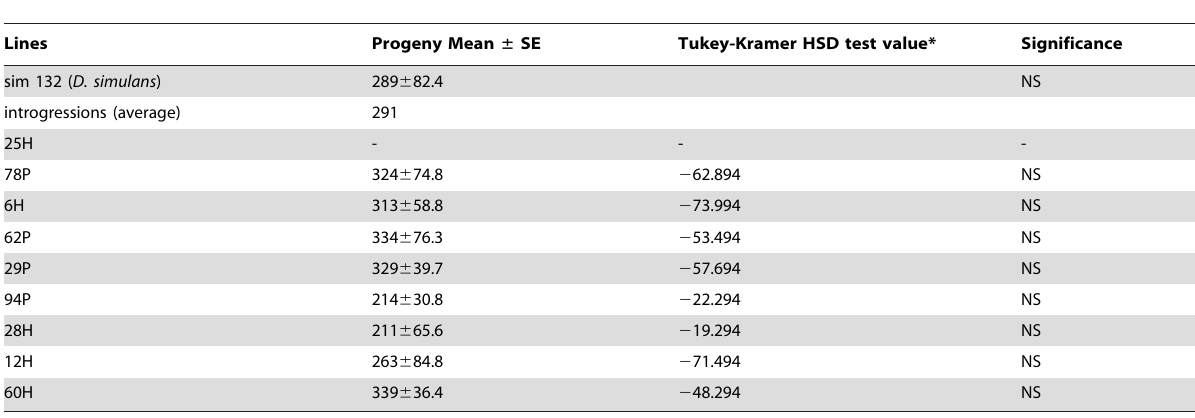
Table 1. Fertility (viability + fecundity) assays of introgression lines and the simulans strain.